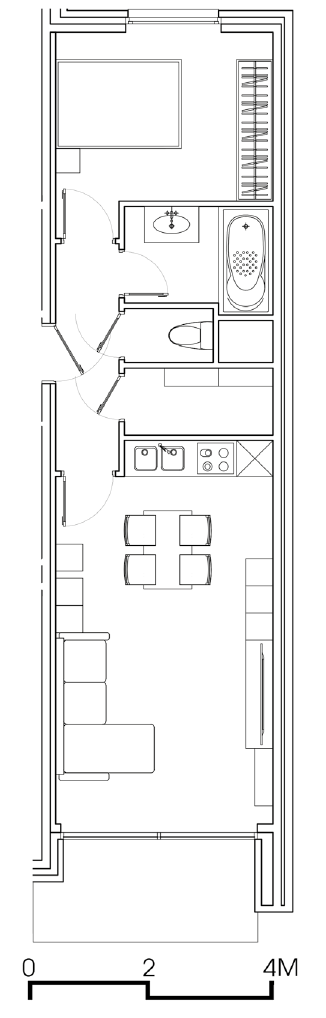
FIG. 5 Leo chose a one-bedroom apartment on the fifth floor so he could see his car on the back deck from the window of the